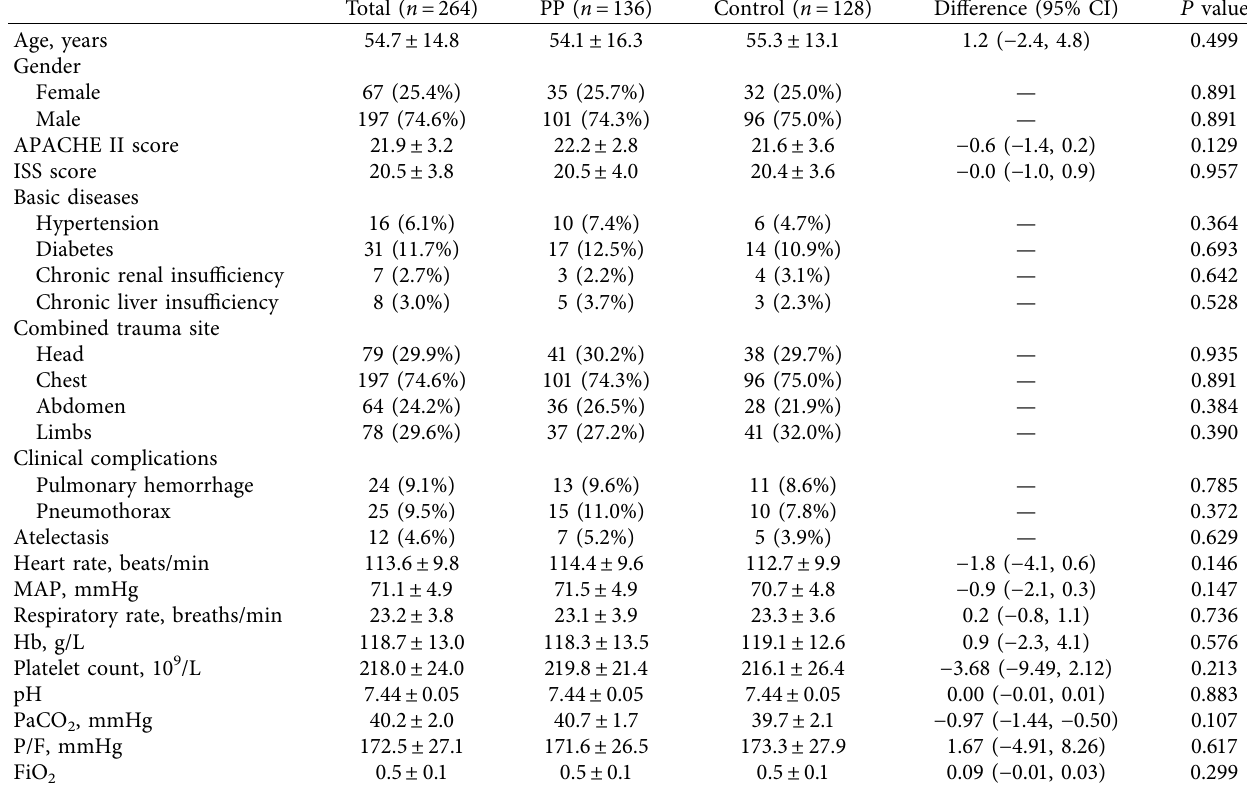
Table 1: Demographic, clinical, and laboratory findings upon entry to the ICU.